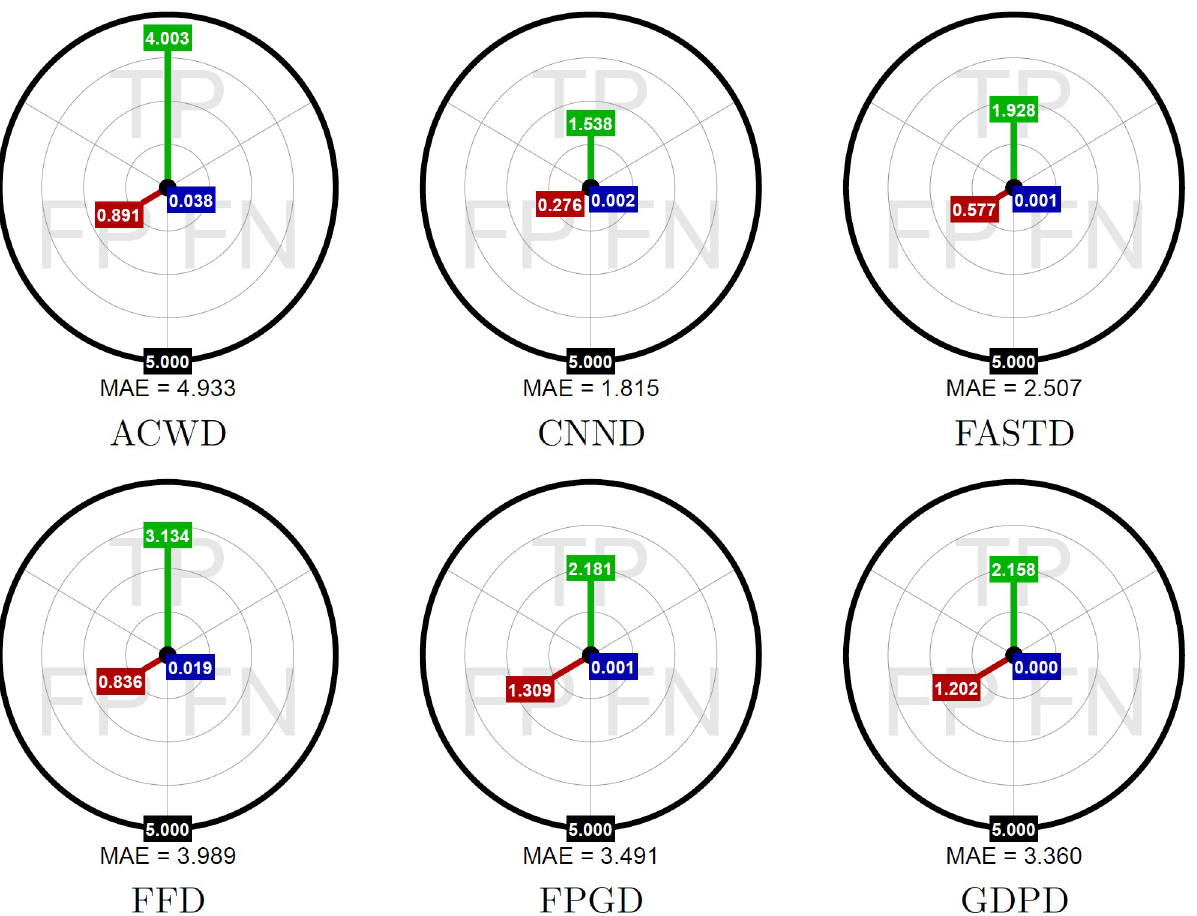
Fig 4. Aim-plots. Shows MAE caused by TP, FP, and FN results separately (CNNE was used as the corrupted pixels restoration